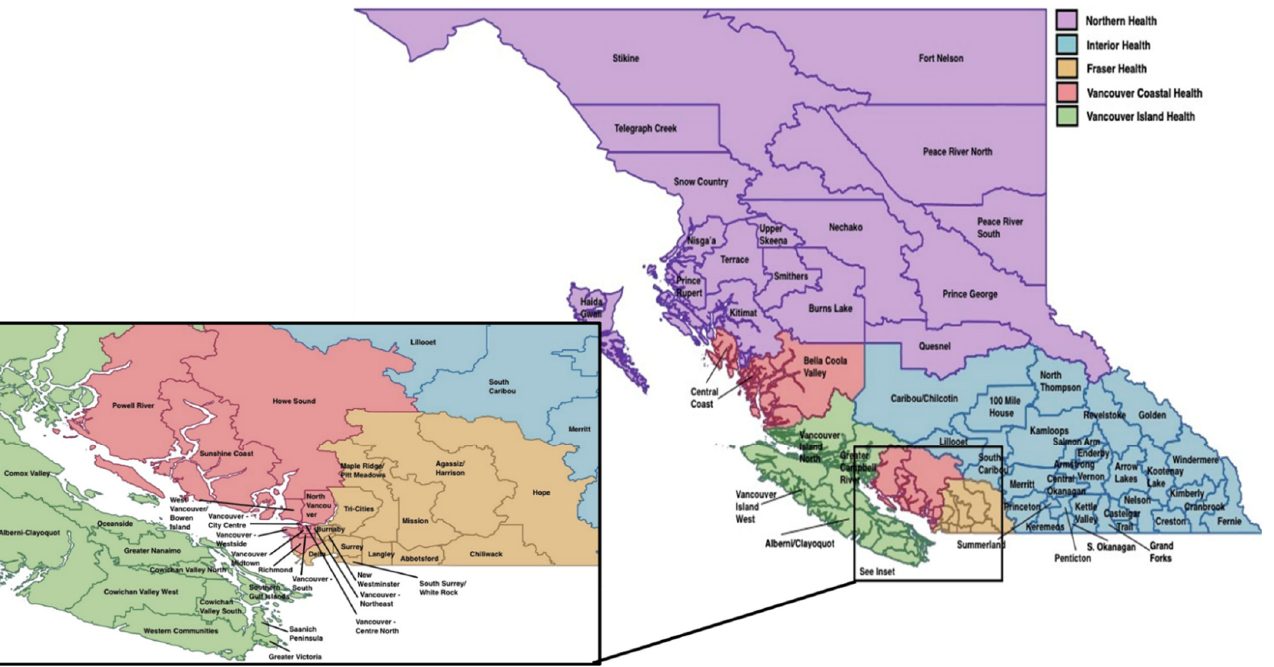
Figure 1. The five regional health authorities and corresponding Local Health Areas in British Columbia, Canada.